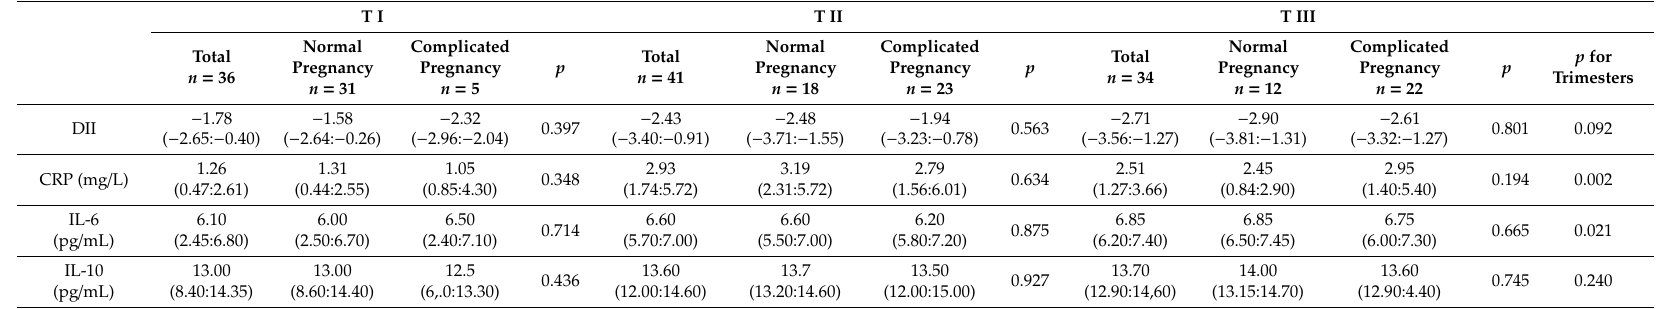
Table 2. Median of DII score and serum CRP, IL-6, and IL-10 levels during pregnancy, median (min:max). T I T II T